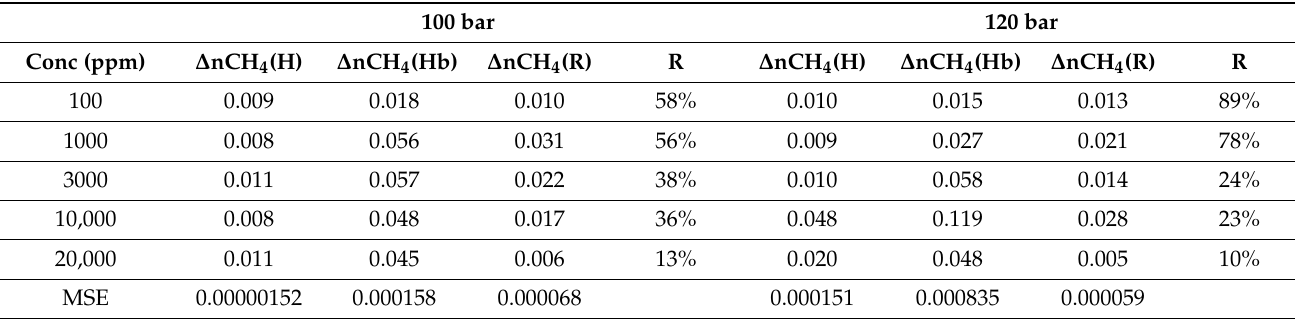
Table A8. Total mole of CH 4 released in the presence of histidine at T = − 2 ◦ C. ∆ nCH 4 (H) is moles of CH 4 stored in hydrate at T = 1 ◦ C. nCH 4 (Hb) is moles of CH 4 stored in hydrate at T = − 2°C. ∆ nCH 4 (R) is the moles of CH 4 release. R is the ratio of mole released/mole stored in hydrate with in 24 h.